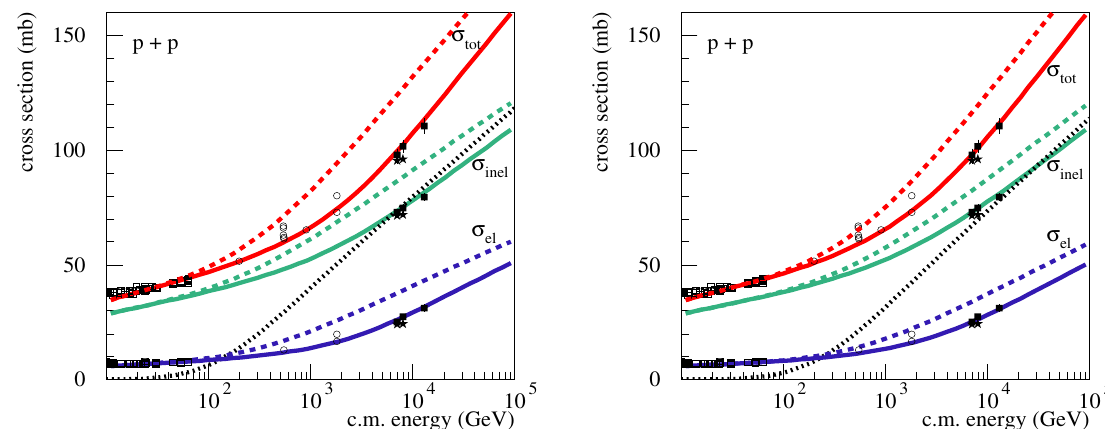
Figure 9. Energy-dependence of the calculated total, inelastic, and elastic proton-proton cross sections, = 1 GeV 2 ( left ) and Q 2 = 1.5 GeV 2 ( right ), obtained taking the for the soft-hard separation scales Q 2 0 0 HT corrections into account (solid lines) or neglecting them (dashed lines). The dotted lines correspond ( jet ) to σ inel pp calculated in a “minijet”-like way, as explained in the text. The experimental data are from Refs.